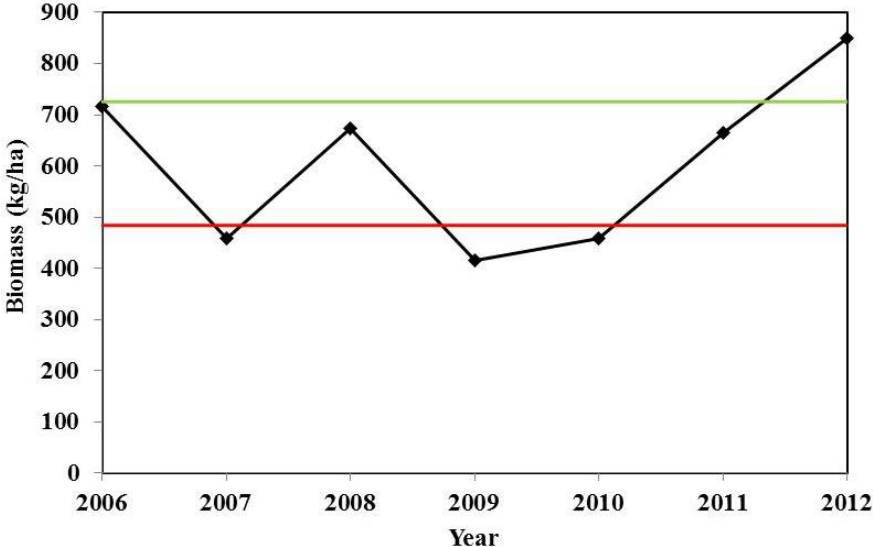
Figure 5. Biomass variation in Xilingol grassland from 2006 to 2012. The green line is the Harvest Year threshold, and the red line is the Lean Year threshold. The black line is the interannual variation of biomass estimation.